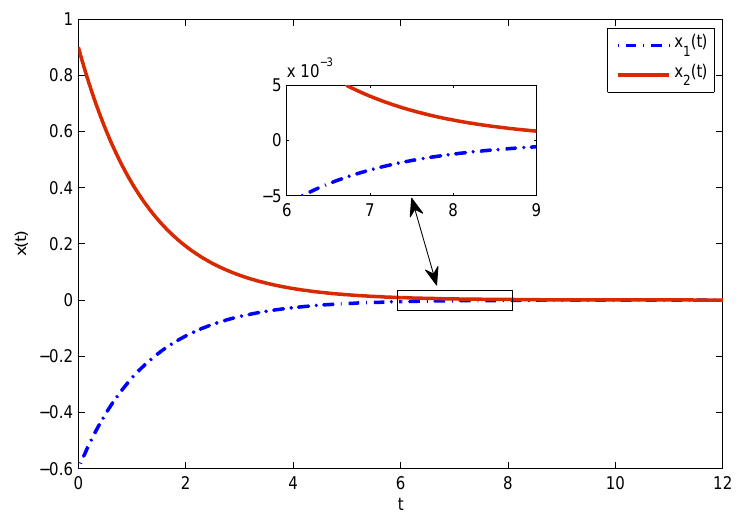
Figure 5. The state trajectories under controllers u 5 ( t ) and u 6 ( t )